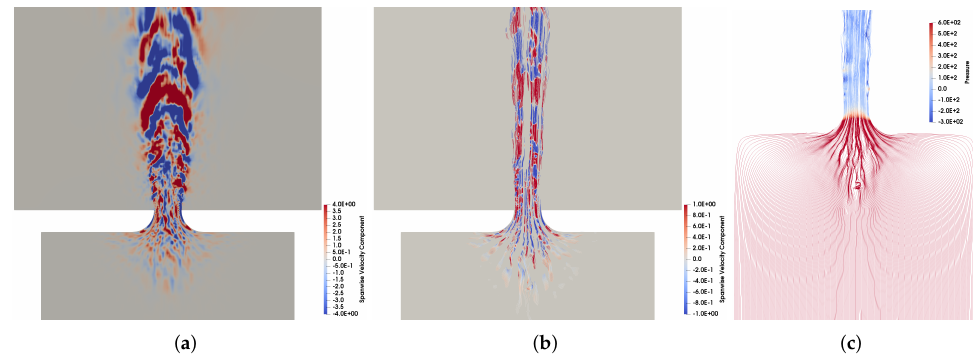
Figure 9. Contours of the spanwise velocity component can be used to highlight the development of instabilities and turbulent flow in the shock absorber as this component should remain negligible, by symmetry, unless some form of three-dimensional flow structures are detected. The field development here is consistent with the vorticity magnitude contours seen in Figure 8. Traces of the streamlines are plotted to visualise the unsteadiness upstream of the orifice and show the potential cause, which is the influence of the flow turning at the orifice boundary that creates a converging flow around the axis of symmetry rotating the flow from the radial to the streamwise direction. ( a ) Spanwise velocity component. ( b ) Streamlines coloured by spanwise velocity component. ( c ) Streamlines showing disturbances upstream of the orifice, coloured by pressure.